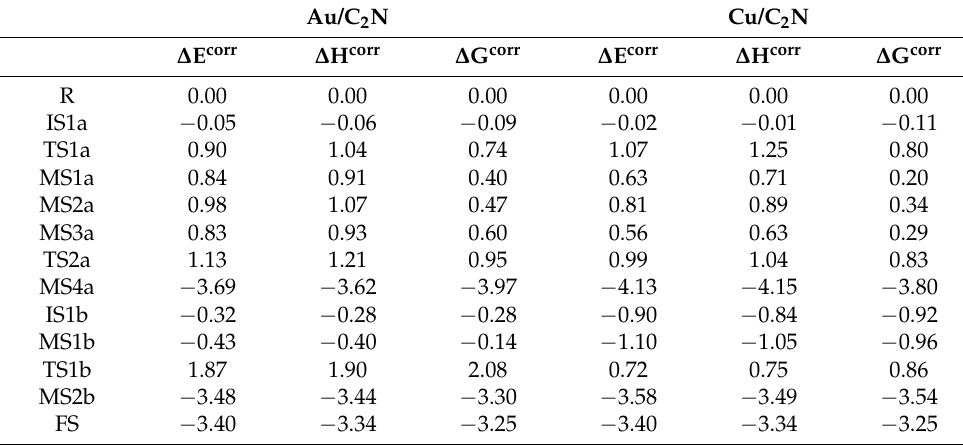
Table 1. Relative energy ( ∆ E corr ), enthalpy ( ∆ H corr ) and free energy ( ∆ G corr ) with zero-point vibra- tional correction for all the species in the both reactions. (unit: eV). Au/C 2 N Cu/C 2 N